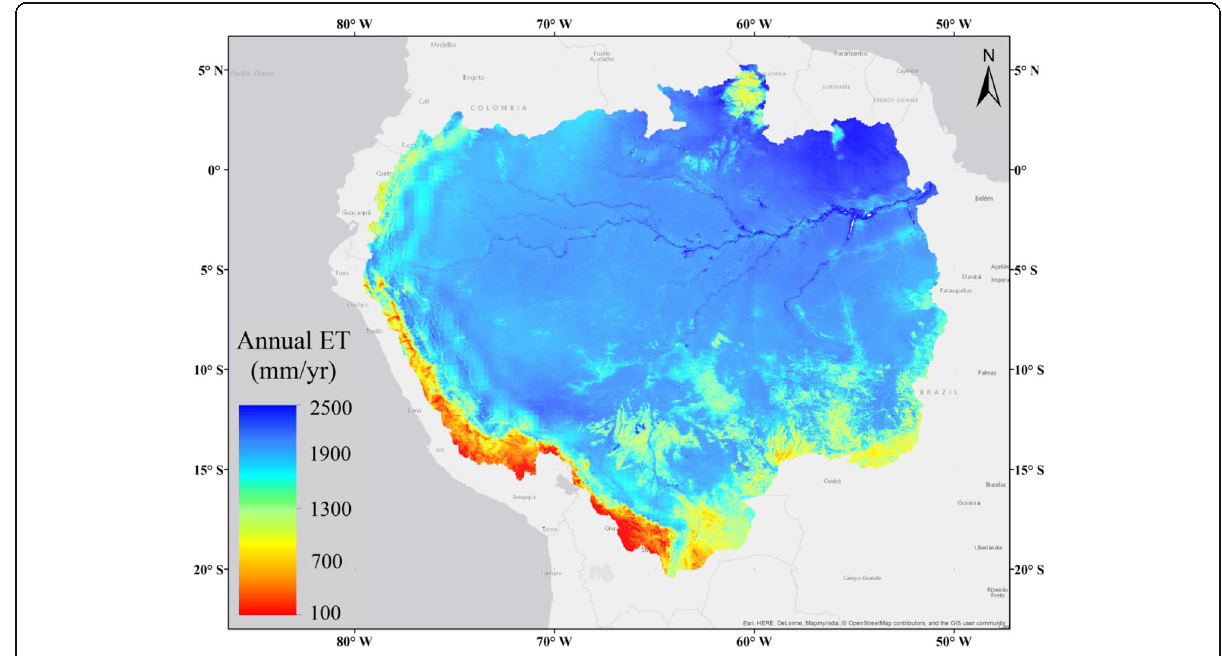
Fig. 6 Spatial distribution of annual ET over the Amazon basin, averaged for the period 2003 to